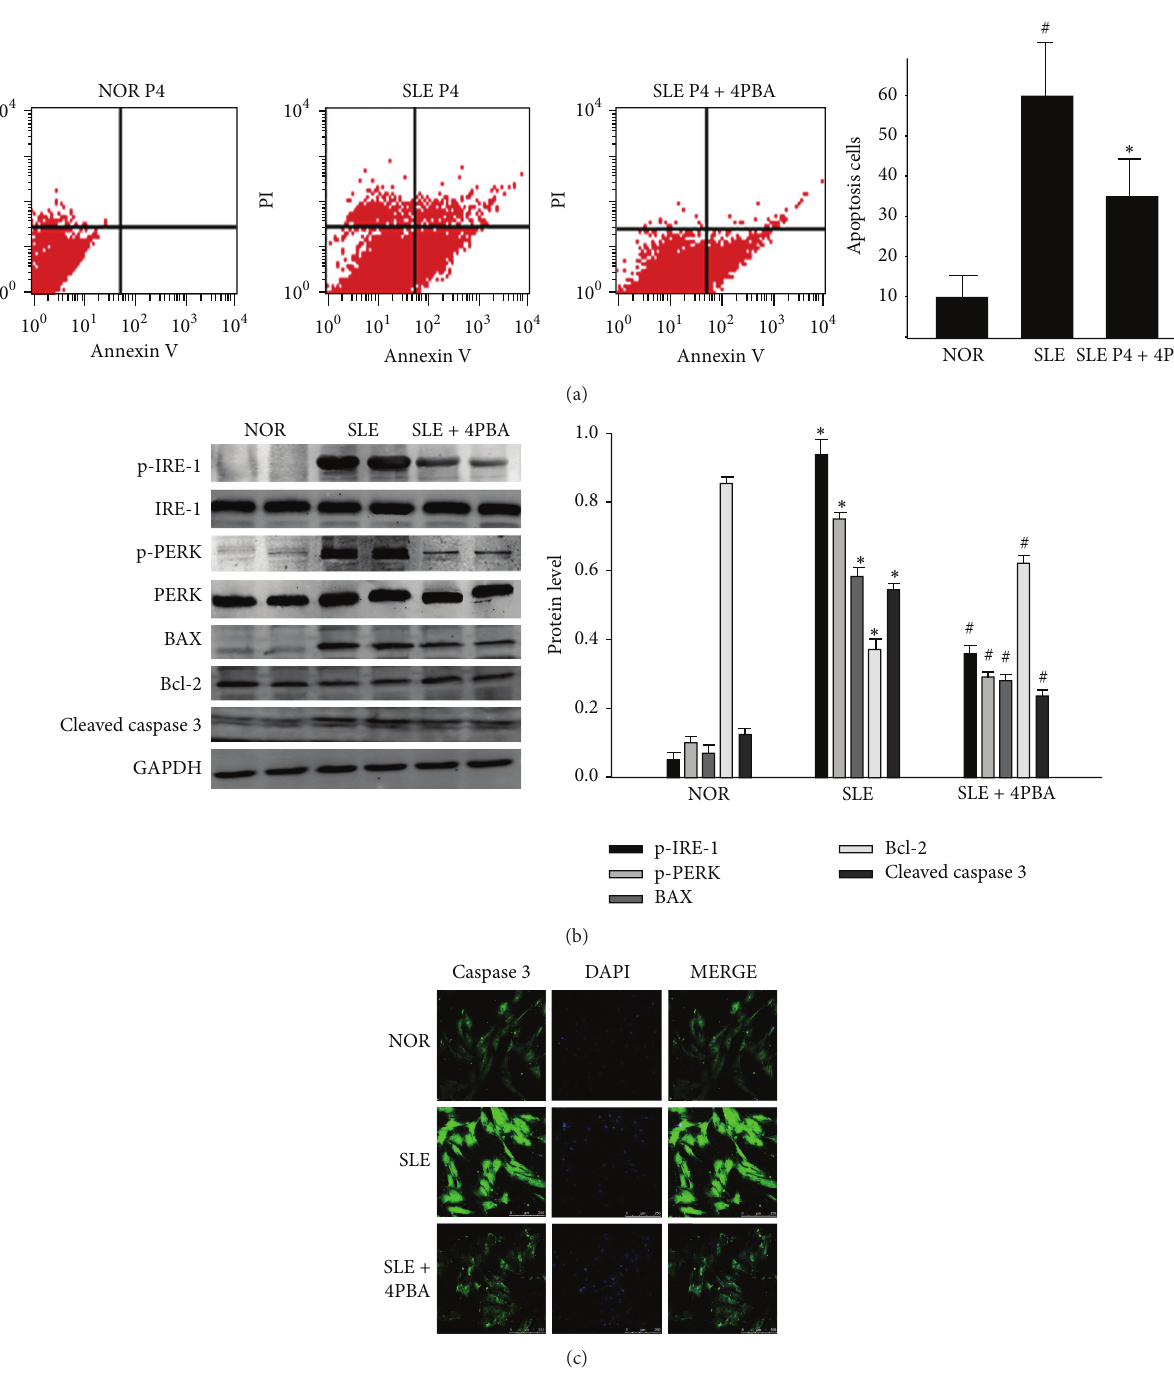
Figure 3: Intervention to ERS can partly rescue the apoptosis of BM-MSCs from SLE patients. BM-MSCs of SLE patients and normal controls were treated with (+) or without ( − ) 4-PBA (100 𝜇 M) from the same time point for the indicated time. (a) Cell viability was assessed by FCM analysis. (b) Cell lysates were analyzed for the levels of p-IRE-1, p-PERK, BAX, Bcl-2 and cleaved caspase-3 via western blot. (Bar represents mean ± SD, ∗ 𝑃 < 0.05 compared with the normal group, # 𝑃 < 0.05 compared with the SLE group). (c) Immunofluorescence analysis was used to analyze the level of cleaved